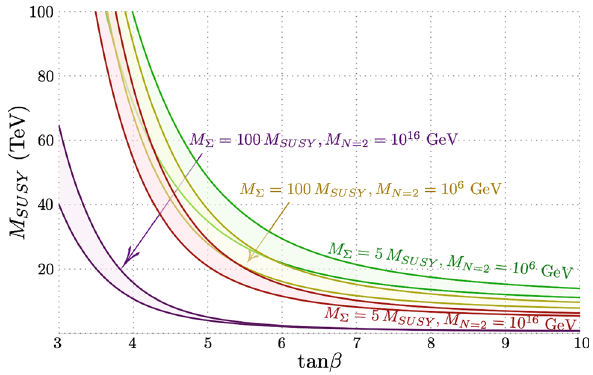
√ Fig. 11 v Z 1 ( M SUSY ) against tan β for N = 2 scales 10 6 and 10 16 GeV,correspondingtothe“tree-level”valueof m h beforerunningdown in low-energy effective theory